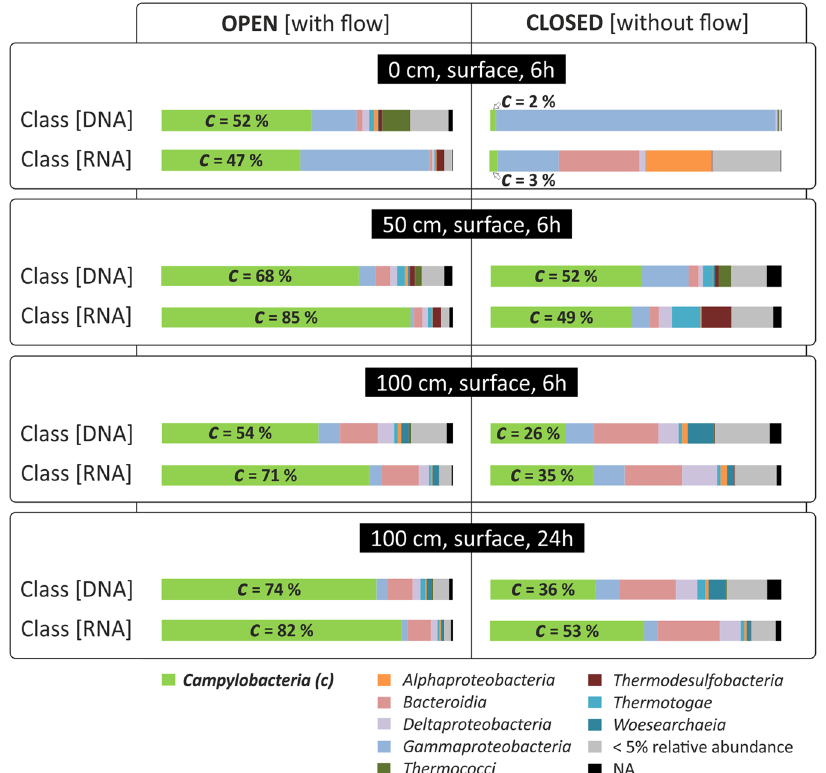
Fig. 4 Microbial diversity at the class level. Microbial diversity at the class level (>5% relative abundance) based on 16 S rRNA gene (DNA) and 16 S rRNA (RNA) in surface samples from open and closed incubations along the transect at 0, 50, and 100 cm. Classes present at a relative abundance of <5% were combined. NA not assigned.